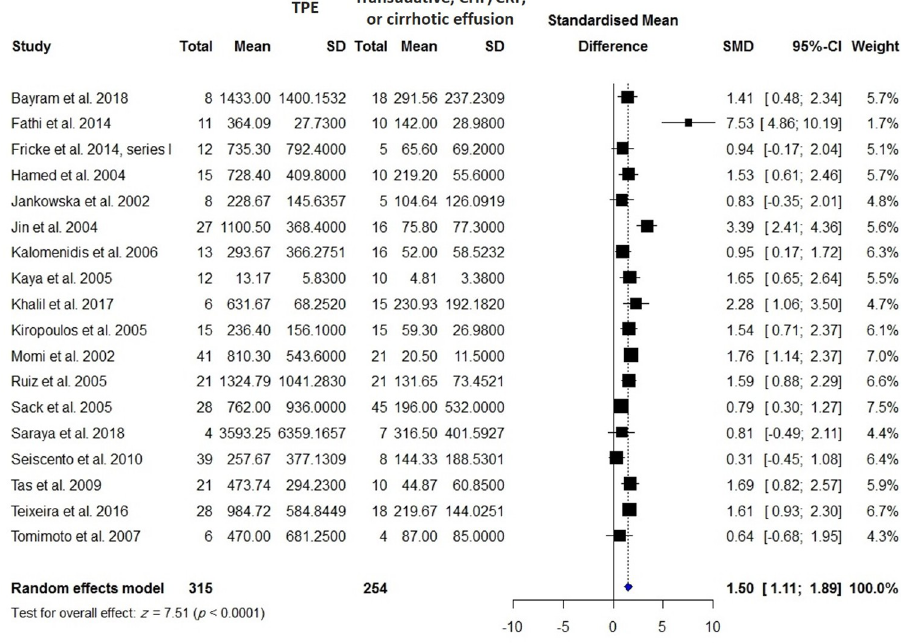
Fig 8. Meta-analysis of blood VEGF levels in patients with TPE vs. patients with transudative, CHF/CRF, or cirrhotic effusion.